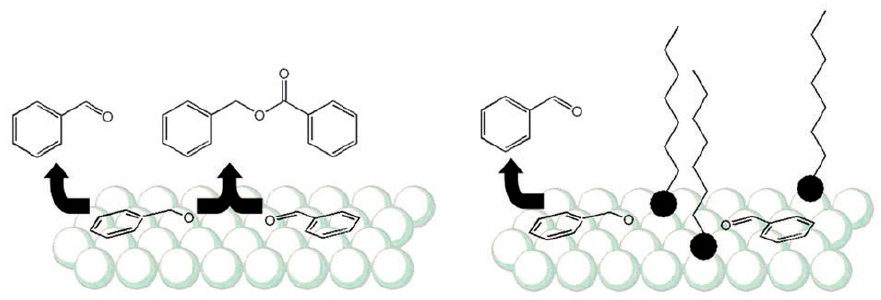
Figure 10. Active site isolation effect in benzyl alcohol oxidation. Reproduced from ref. [83] with permission of The Royal Society of Chemistry.